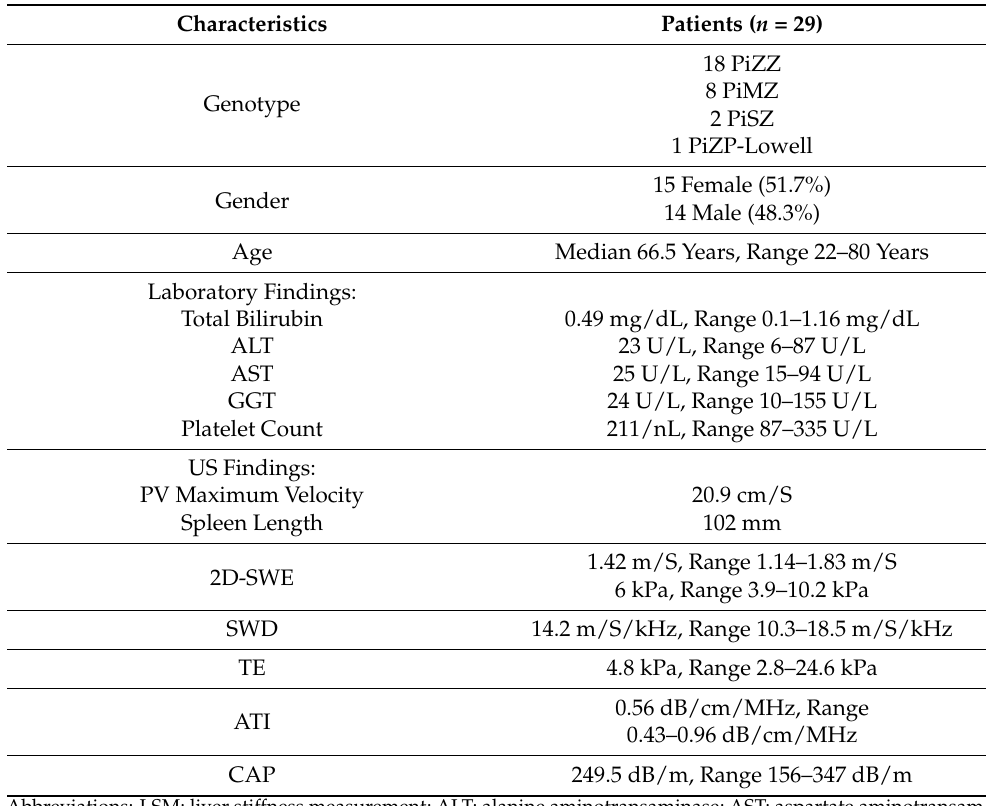
Table 1. Patient characteristics, LSM findings and steatosis